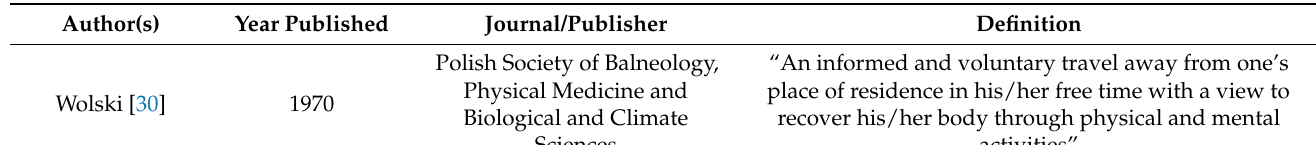
Table 1. Selected definitions of health tourism found in the relevant